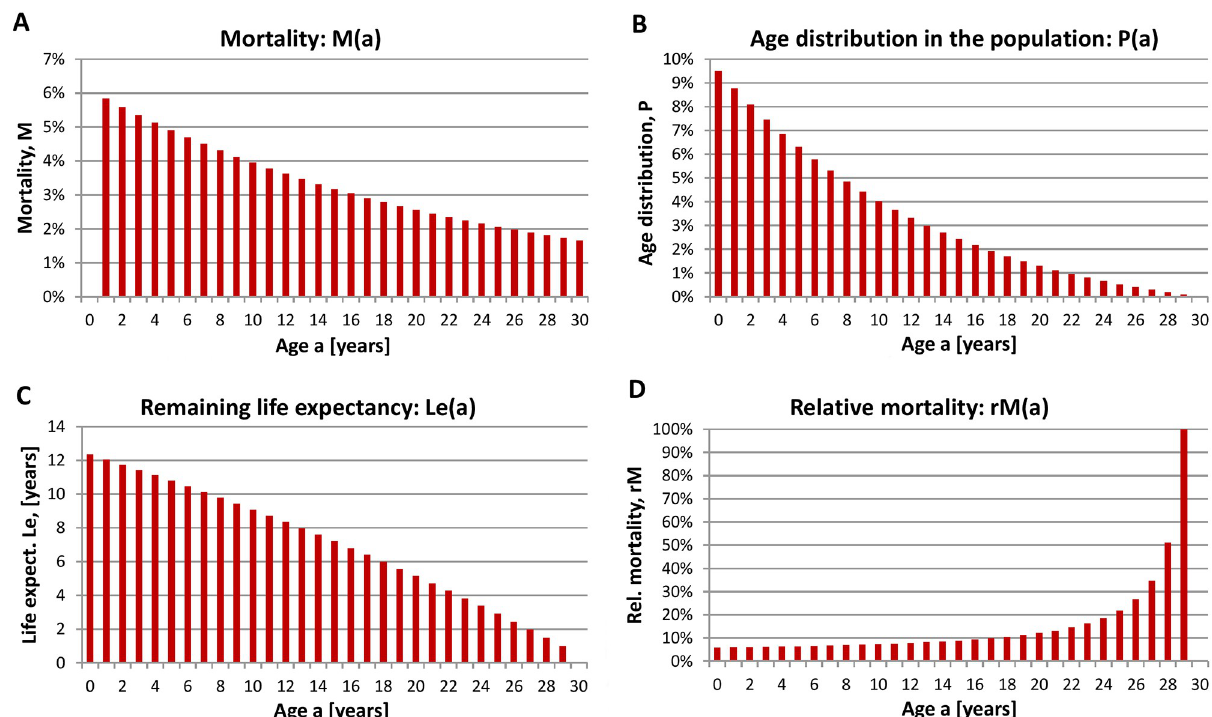
Fig 2. Population dynamics of Common Cranes. (A) Mortality, M(a) (probability of dying at a given age), (B) age distribution in the October population P(a), (C) remaining life expectancy at a given age Le(a), and (D) relative mortality rM(a) (probability of dying when a certain age has been reached) of the Common Crane. Calculations are based on age-differentiated bird counts determined during October in Germany (2012–2020) north- east of the geographic coordinates 12˚00 E, 53˚00 within Germany (mainly Mecklenburg-Vorpommern and the northern part of Brandenburg). Raw data are from the database ornitho . de .